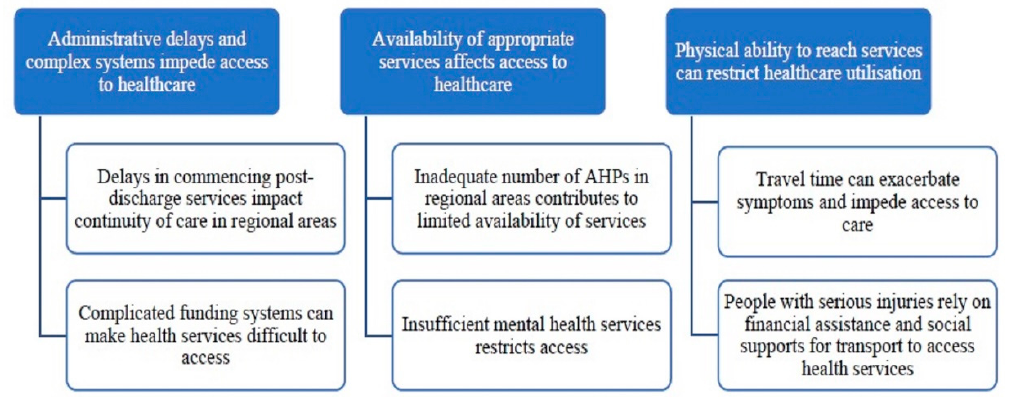
Figure 1. Thematic framework of key themes and subthemes.